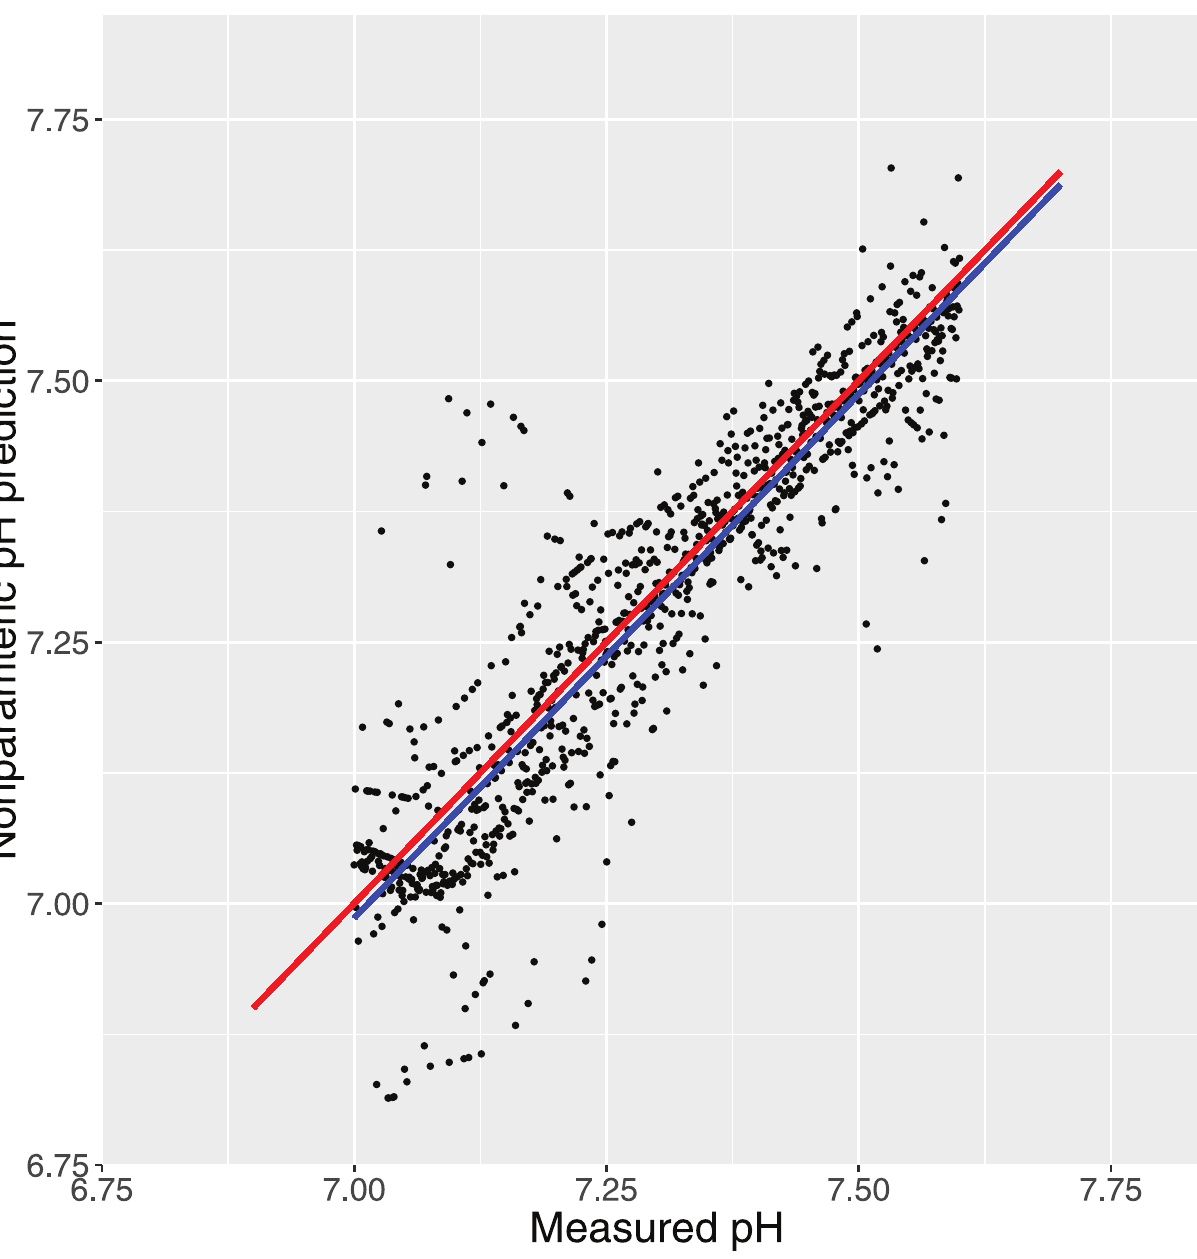
PLOS ONE | DOI:10.1371/journal.pone.0162872 September 15,